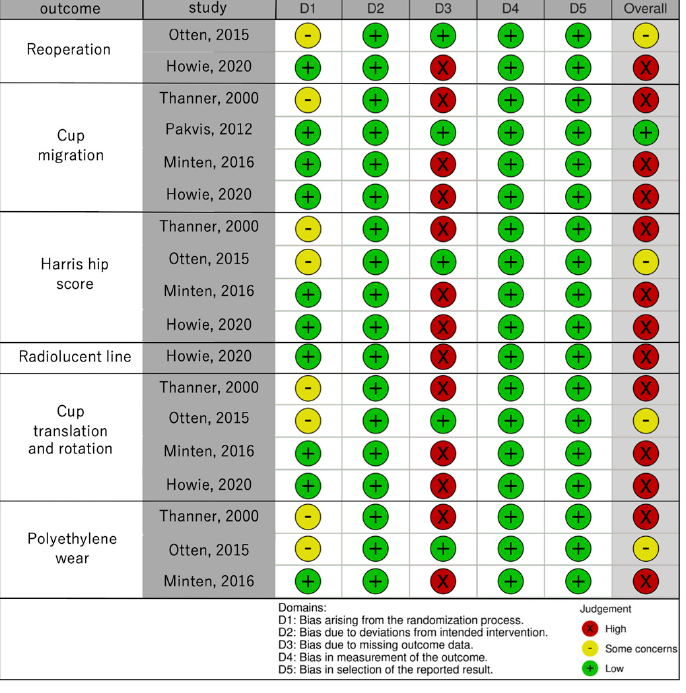
Figure 2. Risk-of-bias summary [8,10–14]. Table 1. Characteristics of included studies.